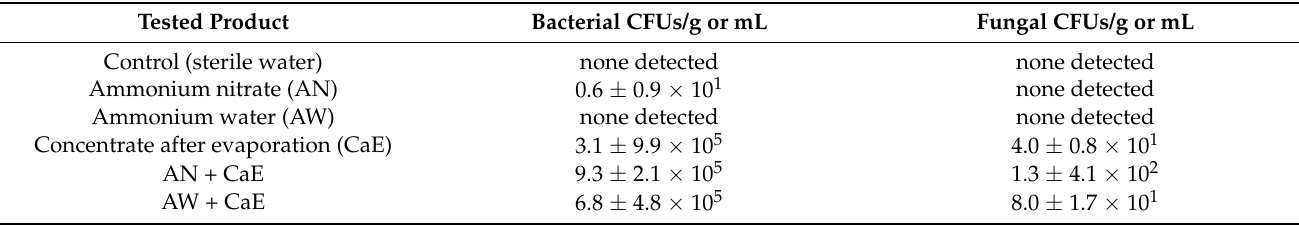
Table 4. Total viable bacterial and fungal mean colony forming units (CFUs) (n = 3) per g or mL of each product and their corresponding standard deviations resulting from total plate